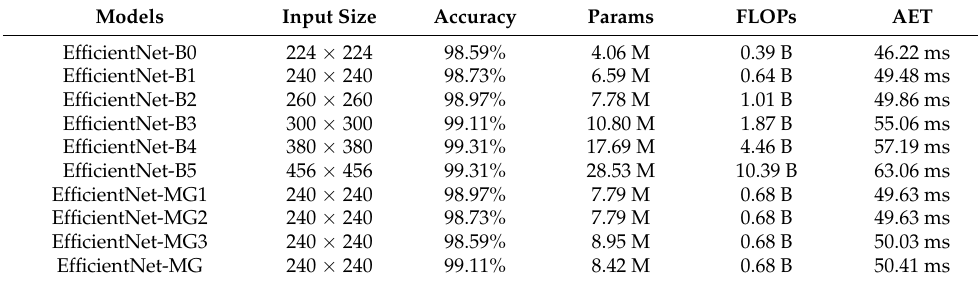
Table 7. Comparative performances between proposed EfficientNet-MGs and EfficientNets.